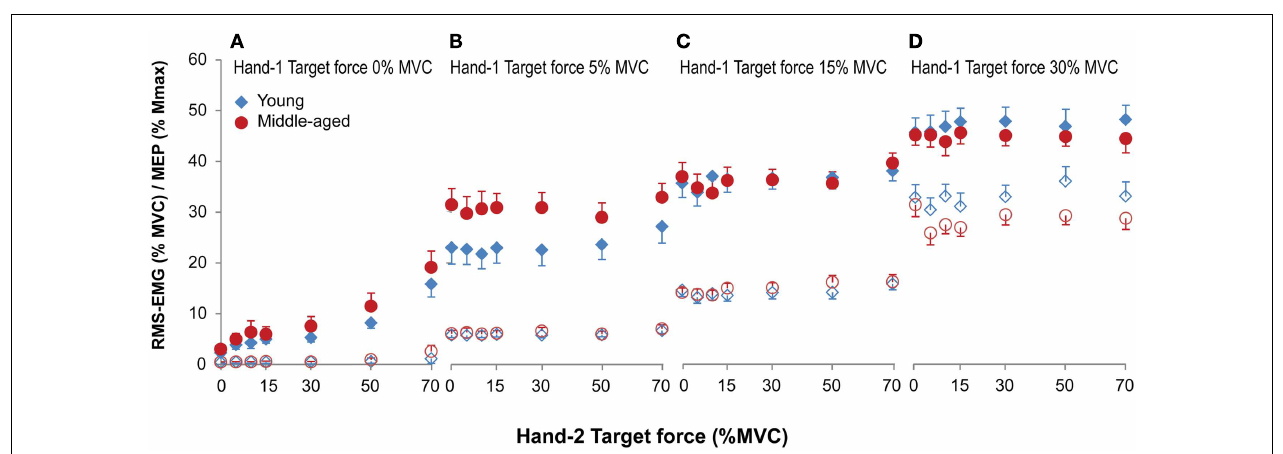
mean values. (A) Shows a small but significant increase in RMS-EMG and an increase in MEP amplitude with increasing ipsilateral force. (B–D) Shows that the RMS-EMG and the MEPs in Hand-1 were affected by both the force production of Hand-1 and -2. At low force levels (5% MVC) MEPs were larger in middle-aged participants, whereas at high force levels (30% MVC) middle-aged participants had lower EMG values compared to young